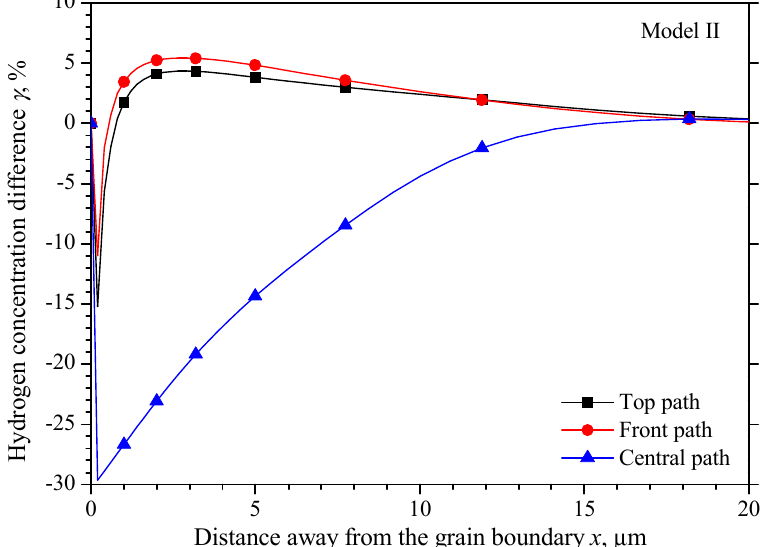
Figure 9. Hydrogen concentration change along observation paths in model II.